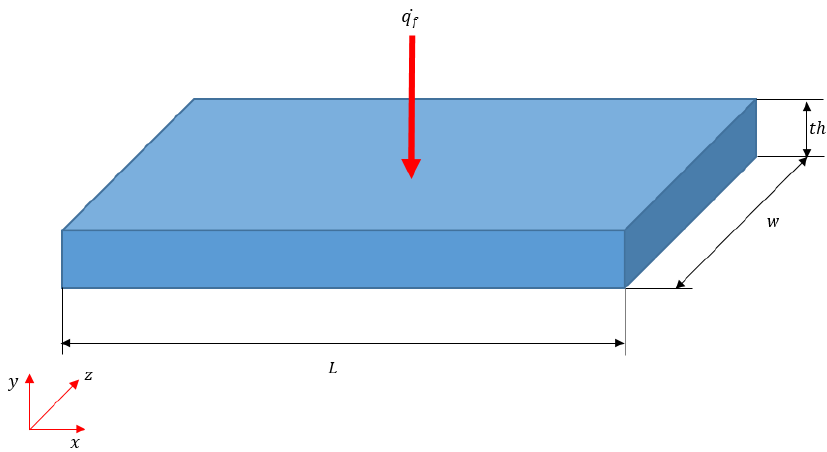
Figure 2. The schematic view of the workpiece and the generated heat by